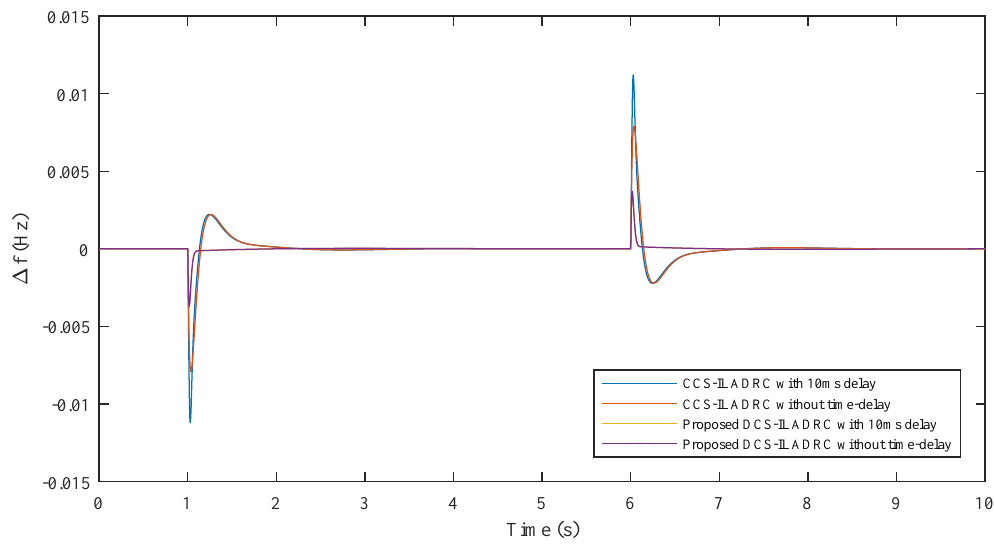
Figure 9. Transient response of the system frequency deviation.